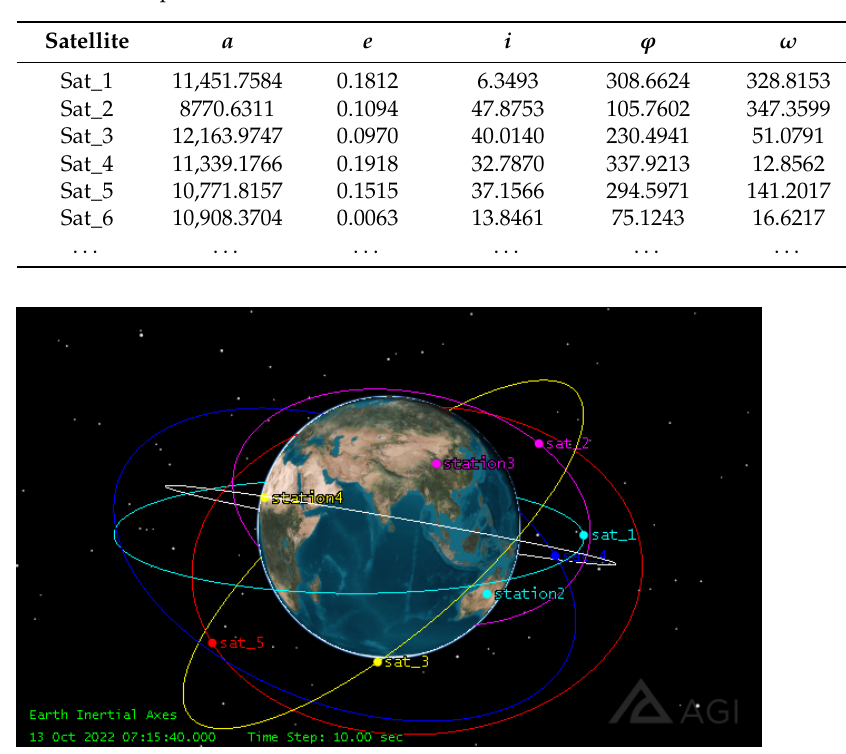
Figure 6. Simulation scenario established through